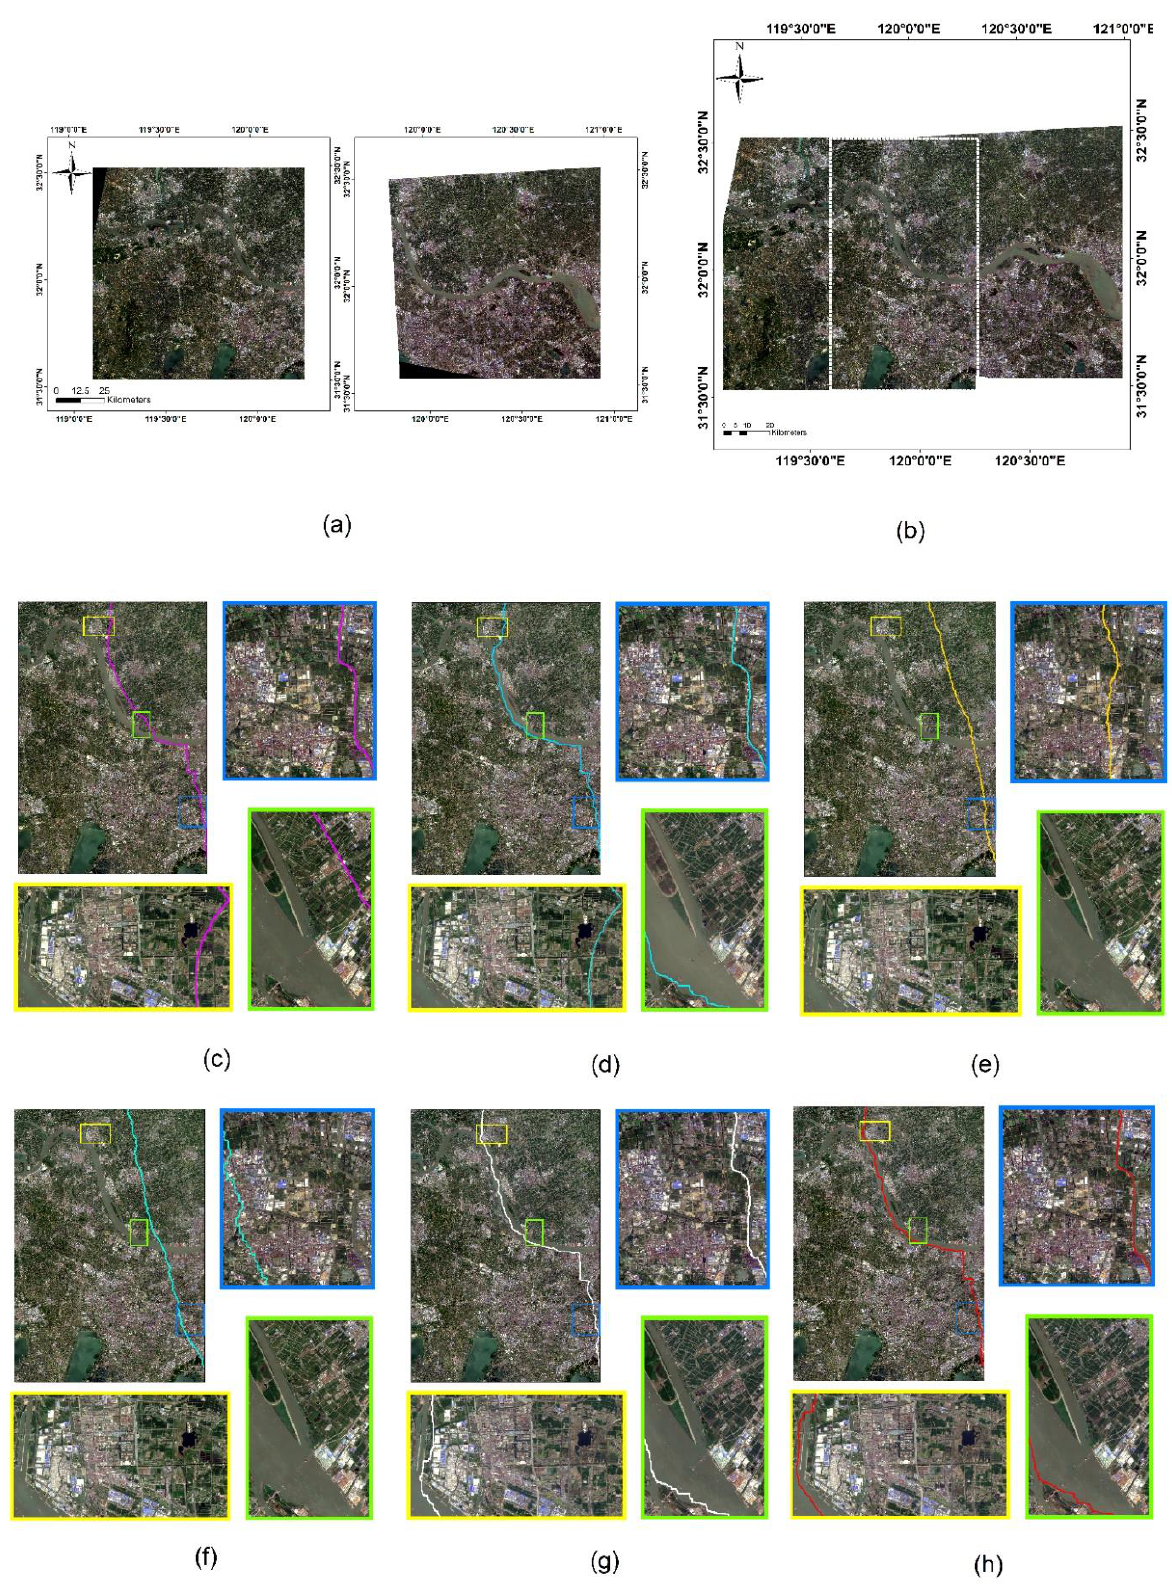
Figure 8. Comparison of the seamlines of Dataset 2: ( a ) original large remote sensing images; the stitching result obtained by ( b ) our method; ( c ) Dijkstra; ( d ) graph cut; ( e ) SLIC+ Dijkstra; ( f ) SLIC+ graph cut; ( g ) resample+ Dijkstra; and ( h ) ours. Three locations are selected to show the refinement differences of the seamlines obtained by different algorithms with rectangular boxes of different colors. The colored line in the image is the